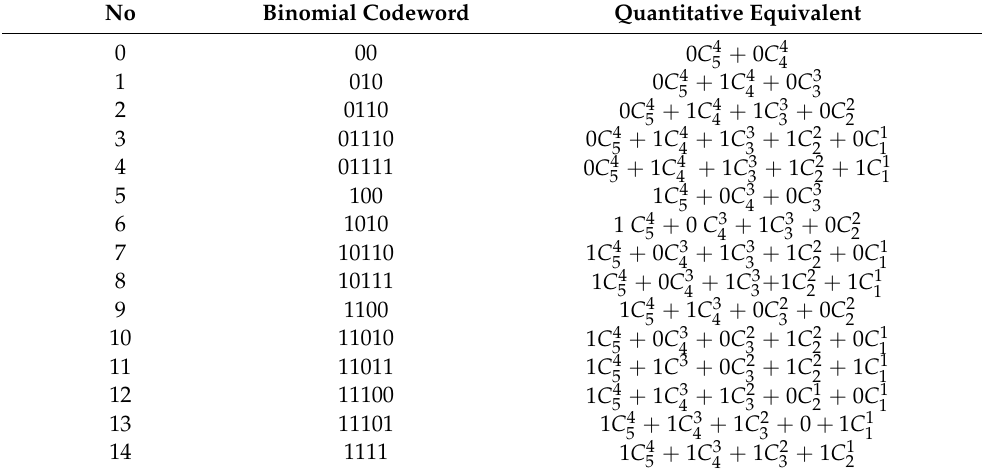
Table 1. Binomial non-uniform codewords with parameters n = 6, k = 4 and quantitative equivalents. No Binomial Codeword Quantitative Equivalent